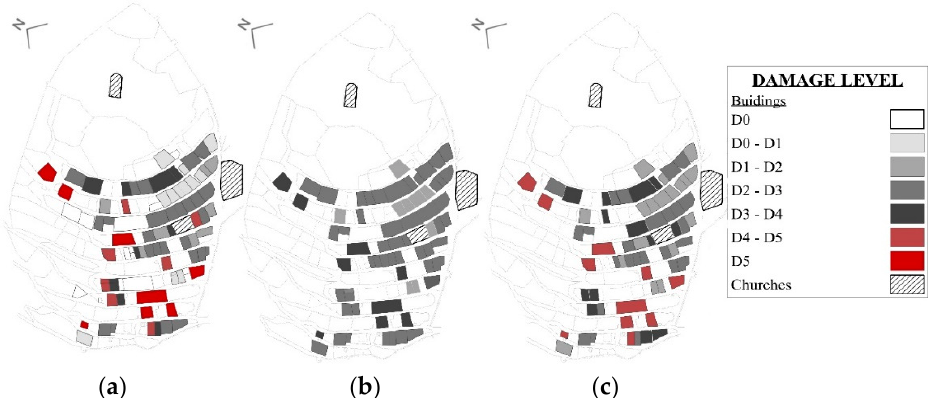
Figure 22. Comparison between ( a ) the damage scenarios of the case study detected after the 2016 seismic events, ( b ) the damage scenarios evaluated with the Vicente method and ( c ) with the calibrated method, considering the IQ index.